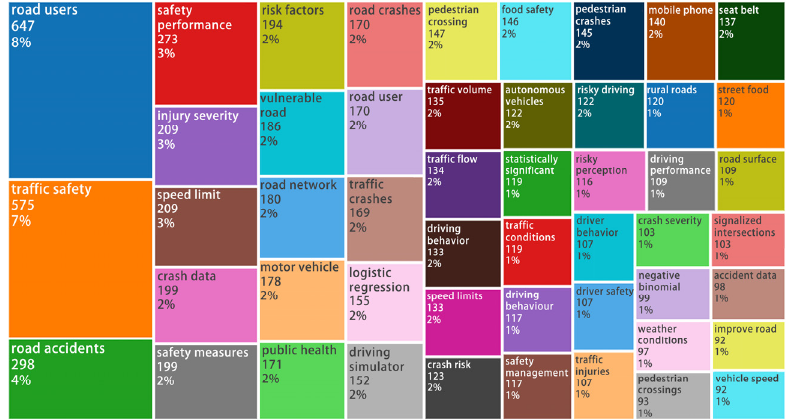
Figure 1. Tree map of street safety research.